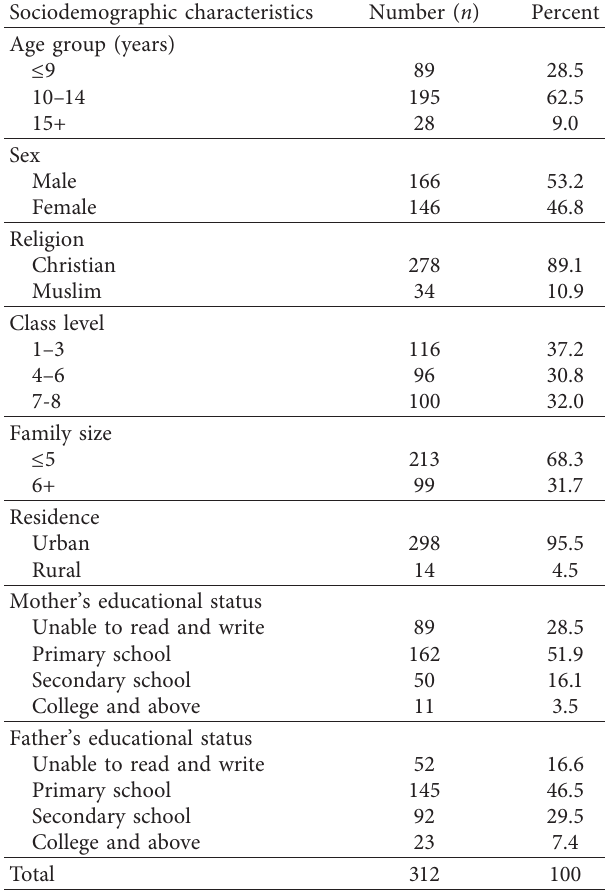
Table 2: Distribution of intestinal parasites according to the sex in the two primary schools in Rama town, Northern Ethiopia.